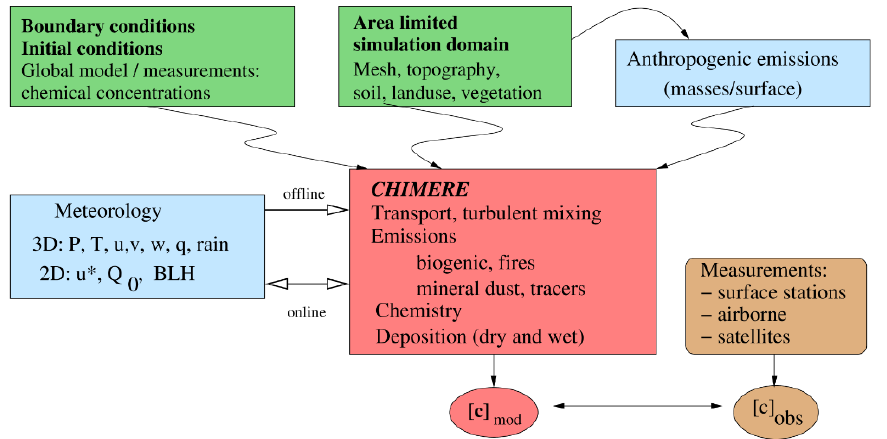
Figure 2. General principle of a chemistry transport model such as CHIMERE. In the box “Mete- orology”, u ∗ stands for the friction velocity, Q 0 is the surface sensible heat flux, and BLH is the boundary layer height. [ c ] mod and [ c ] obs are the modeled and the observed chemical concentrations fields, respectively. This figure is Figure 1.1 from https://www.lmd.polytechnique.fr/chimere/docs/ CHIMEREdoc_v2020r1.pdf (accessed on 13 April